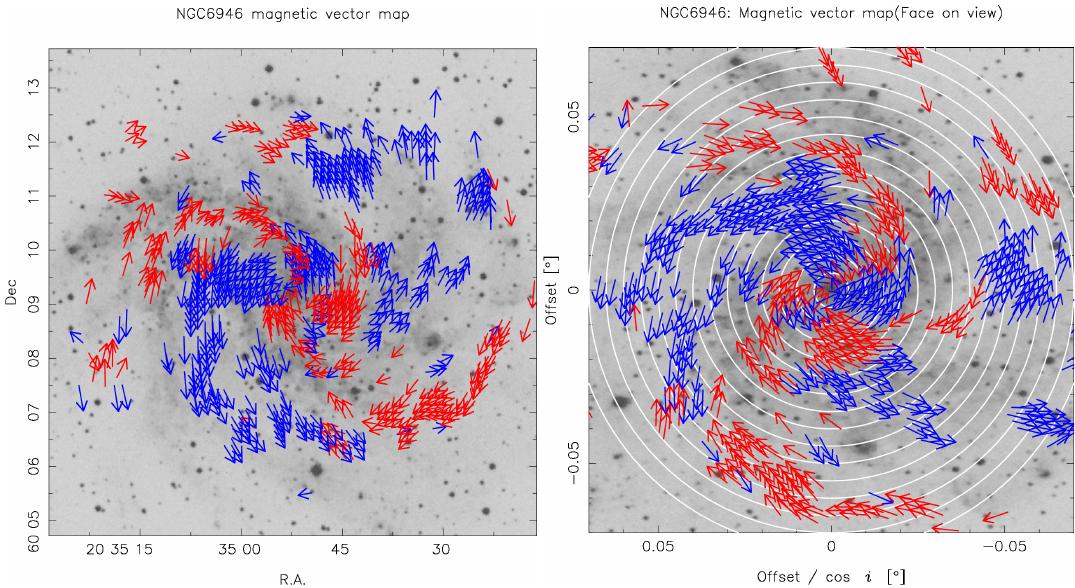
Figure 4. Left : Magnetic vector map overlaid on a black-and-white image from DSS2 B. Red and blue arrows denote inward and outward vectors, respectively. Right : Face-on views of the magnetic vector map overlaid on a black-and-white image from DSS2 B. Circles are overlaid at equidistant 680 pc intervals. This map is constructed by rotating the left panel by the position angle and then horizontally enlarging the outcome by a factor of 1/cos i . Right hand side of the disk is near to